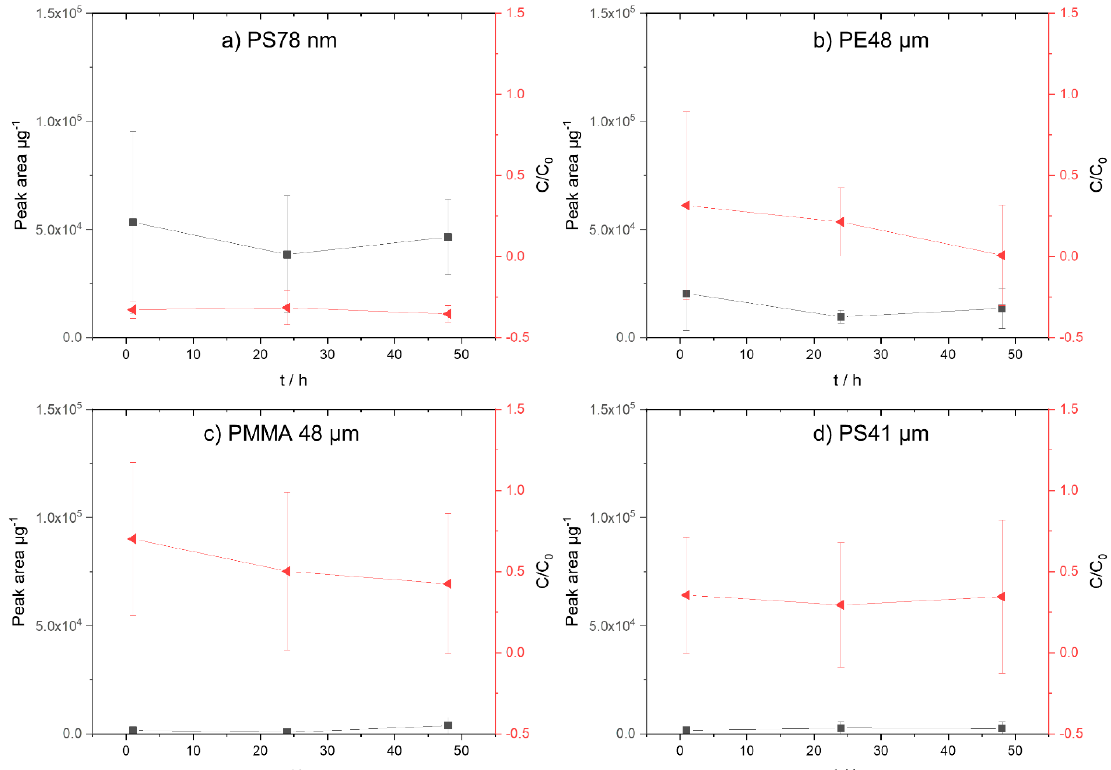
Figure 3. Concentration of triclosan on micro- and nanoplastic particles. On the left y − axis (black, square), the sorption on the particles (peak area µg − 1 ) is shown; on the right y − axis (red, triangle) the concentration in the aqueous phase (C/C 0 ) is presented. ( a ) PS 78 nm, ( b ) PE 48 µm, ( c ) PMMA 48 µm, and ( d ) PS41 µm.